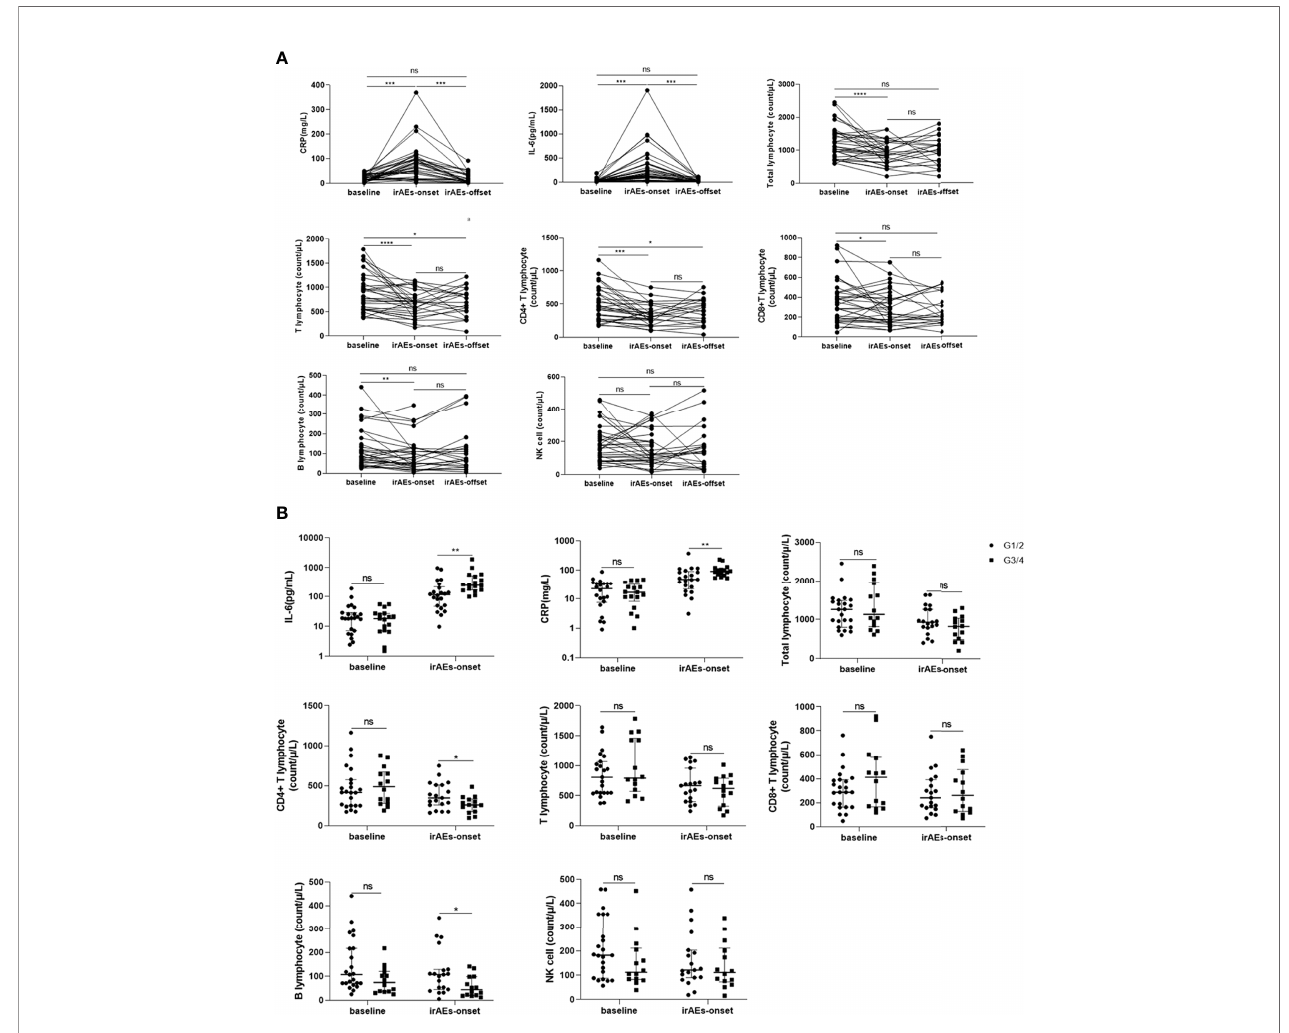
FIGURE 1 | Changes in c-reactive protein (CRP) and interleukin-6 (IL-6) levels with the development of immune-related adverse events (irAEs). (A) Changes inn CRP, IL-6, and lymphocyte subsets at baseline, irAEs-onset, and irAEs-offset in patients with irAEs. (B) Comparison of CRP and IL-6 levels between baseline and irAEs onset in patients with different grades of irAEs. CRP, C-reactive protein; IL-6, interleukin-6; G1: grade 1; G2, grade 2; G3, grade 3; G4, grade 4; * P < 0.05; ** P < 0.01; *** P < 0.001; **** P < 0.000; ns, no statistical